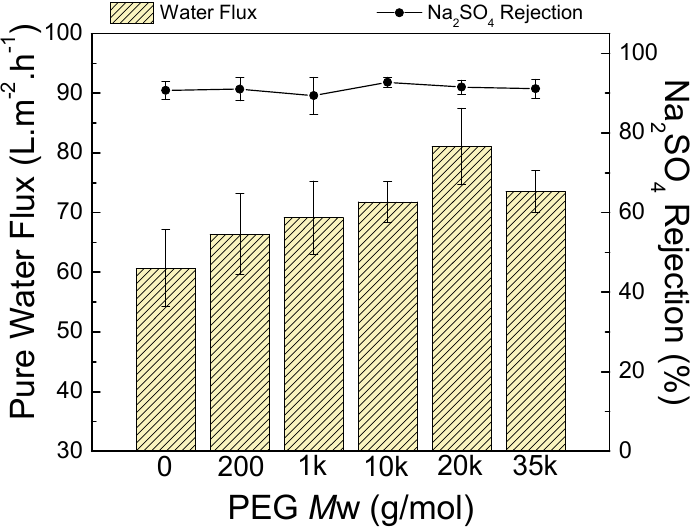
Figure 8. Nanofiltration performance of thin-film composite membranes prepared using PEG of varying molecular weights. Feed = 1000 ppm aqueous Na 2 SO 4 solution. Operating conditions = 0.60 MPa and 25 °C.